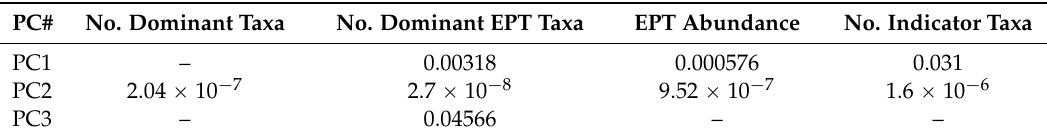
Table 2. p -values for all significant relationships resulting from multiple linear regression between macroinvertebrate metrics and morphology principal components (PCs).